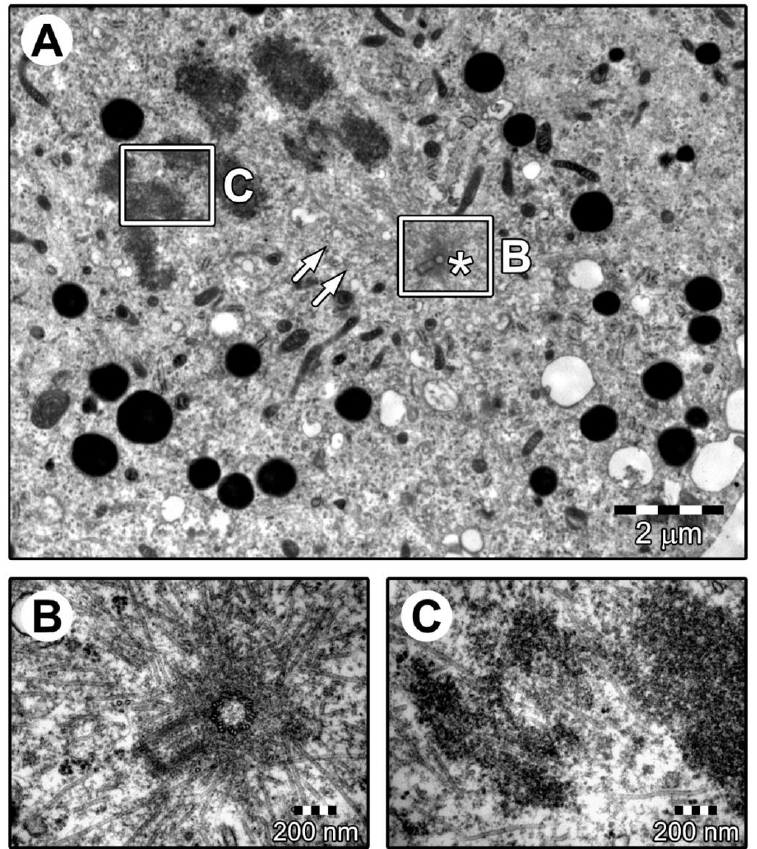
Figure 7. Human ovarian granulosa cells during mitotic division. Human ovarian GC cultures (day 7). Micro-electrophotography showing cells during mitotic division ( A ). The centrosome (star-like shape) is surrounded by a cloud of amorphous material forming a pericentric matrix, along with a radial microtubule system ( B ). Structures of the mitotic spindles (arrows) are visible, connecting to the chromosomes located in the equatorial plane ( C